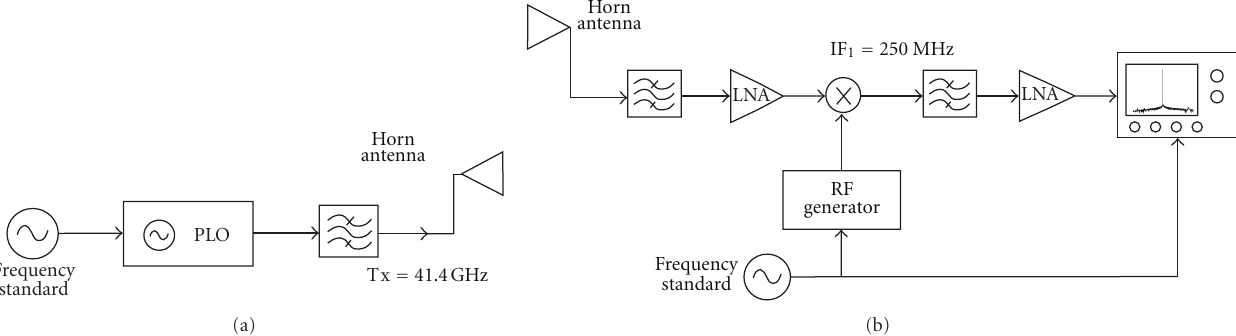
Figure 1: Functional diagram of narrowband sounder used at 41.4 GHz experiments: (a) transmitter and (b) receiver. Table 1: Spectrum analyzer